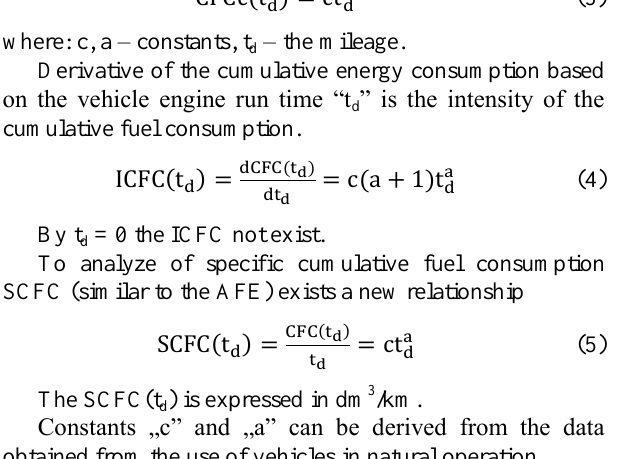
Fig . 2. Cumulative fuel consumption of vehicle nr 770028 The difference between the values of cumulative fuel consumption from operation and those determined using model (3) is not large (it does not exceed 1.5%). It is im- portant, however, that this difference does not assume con- stant values. The course of the cumulative fuel consumption is quasi-linear but not a straight line. The correlation coeffi- cient of the math model R 2 is greater than 0.999 which is an excellent value.